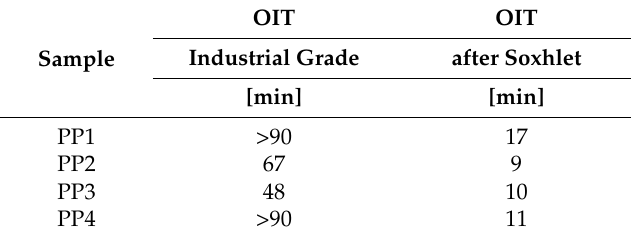
Table 2. OIT before and after Soxhlet extraction of the PPs.